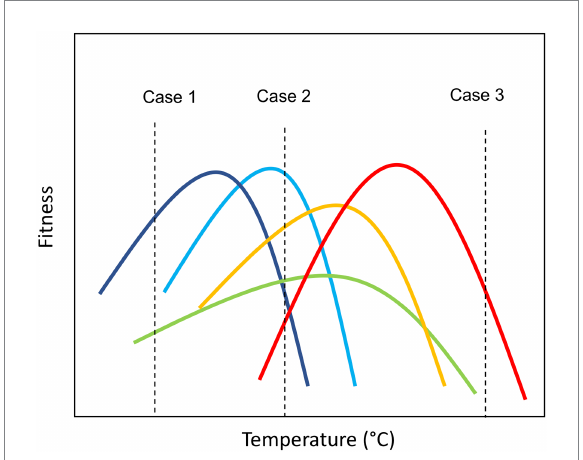
FIGURE 1 Graphical representation of community assembly based on thermal traits under different temperature conditions. Case 1: Community exposed to cold temperature (~10 ° C); Case 2: Community exposed to ambient temperature (~20 ° C); and Case 3: Community exposed to warm temperature (~40 ° C). The vertical axis represents the fitness of the species (e.g., growth rate). Consider, for example, a pool of species with diversity in their thermal tolerance traits, if the species pool is exposed to different thermal scenarios, the taxonomic structure of the assemblage may differ based on the relative fitness of the species’ embodied in their tolerance curves. At benign temperatures where few species experience thermal stress, communities are likely to have high levels of species richness (Case 2). However, under thermal stress, due to either low (case 1) or high temperatures (case 3), communities are likely to move toward being dominated by a few taxa that are able to cope with the (relatively) extreme environmental conditions. These communities are characterized by low species richness and low evenness in the distribution of biomass among species, i.e., the few species that can survive the extreme conditions dominate the